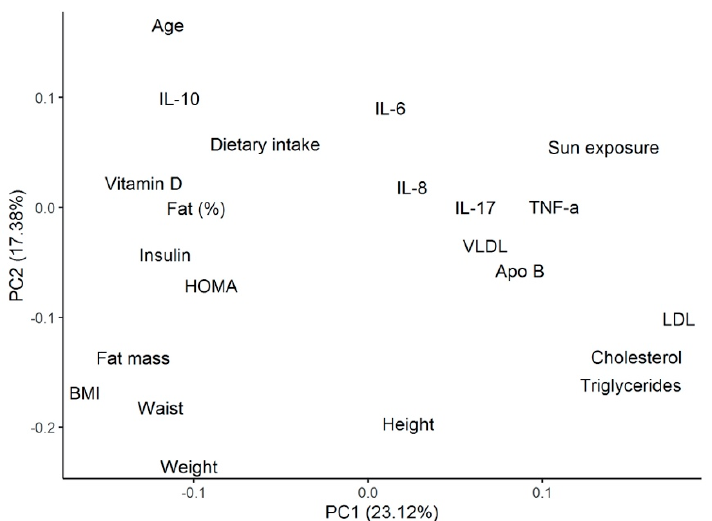
Figure 3. PCA analysis for the metabolic and biochemical variables described in the cluster’s analysis. PCA = principal component analysis; IL = interleukin; HOMA = Homeostatic Model Assessment; BMI = body mass index; TNF = tumor necrosis factor; VLDL = very low-density lipoprotein; Apo = apolipoprotein; LDL = low-density lipoprotein.